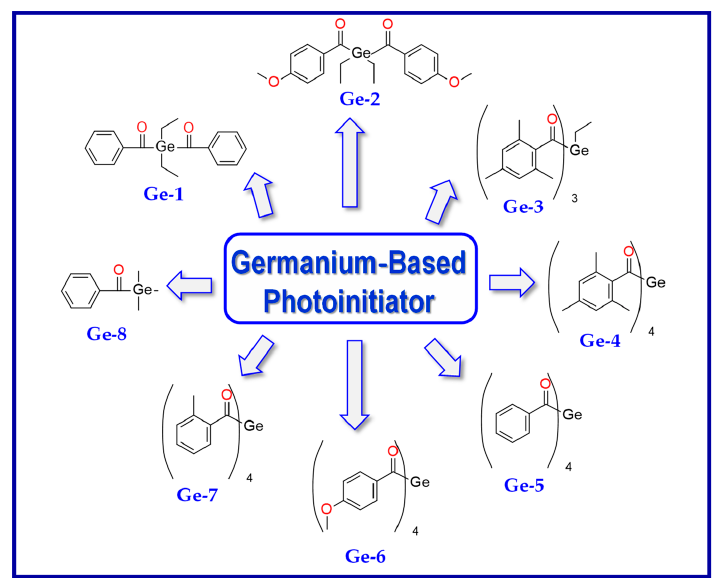
Figure 11. Structure of novel germanium derivatives.